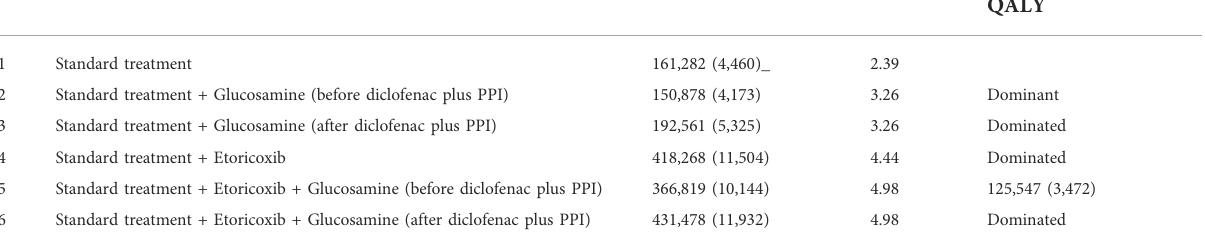
TABLE 3 Base-case results.